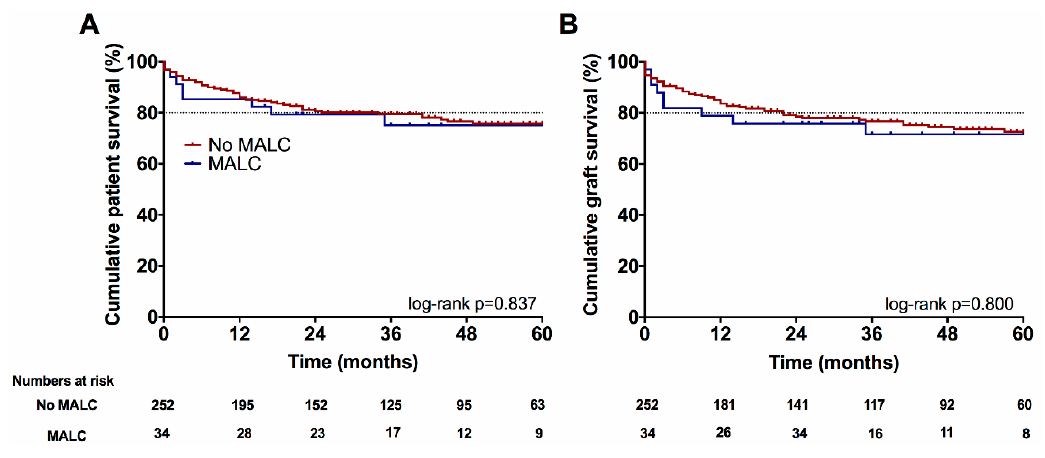
Figure 2. Kaplan–Meier plots for cumulative patient and graft survival Overall patient and graft survival with and without MALC (75% vs. 76%, p = 0.837; 72% vs. 73%, p = 0.800, respectively). Abbreviations used: MALC, median arcuate ligament syndrome/Dunbar syndrome. Abbreviations used: MALC, median arcuate ligament syndrome / Dunbar